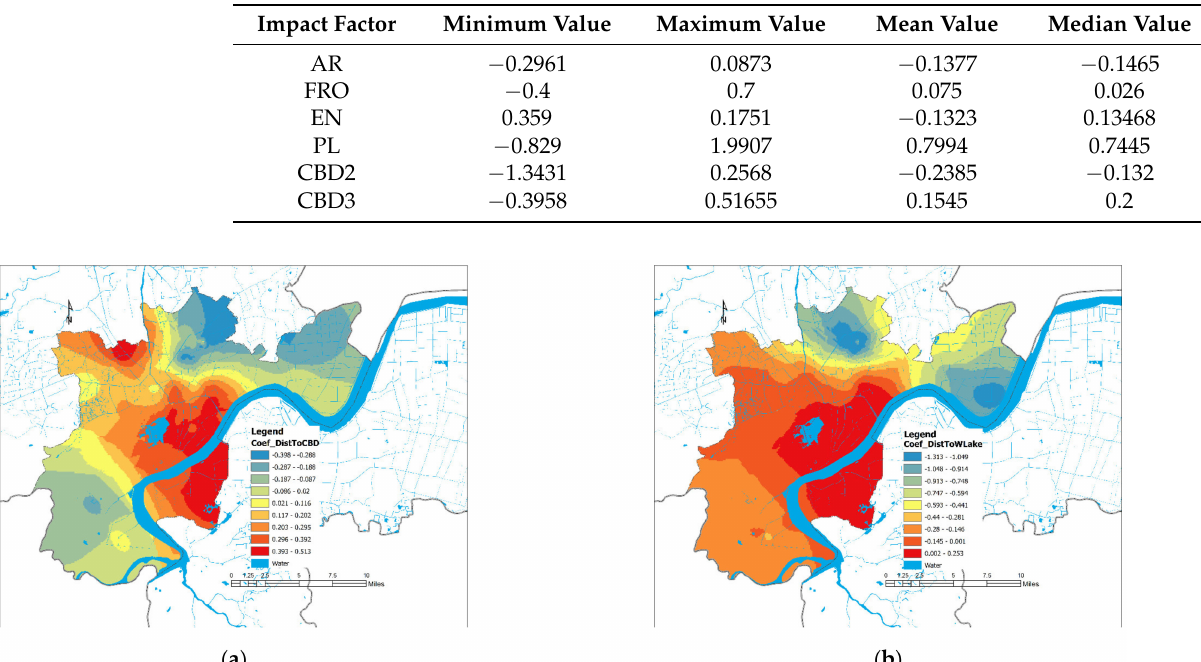
Table 12. GTWR regression results of commercial land category 1.